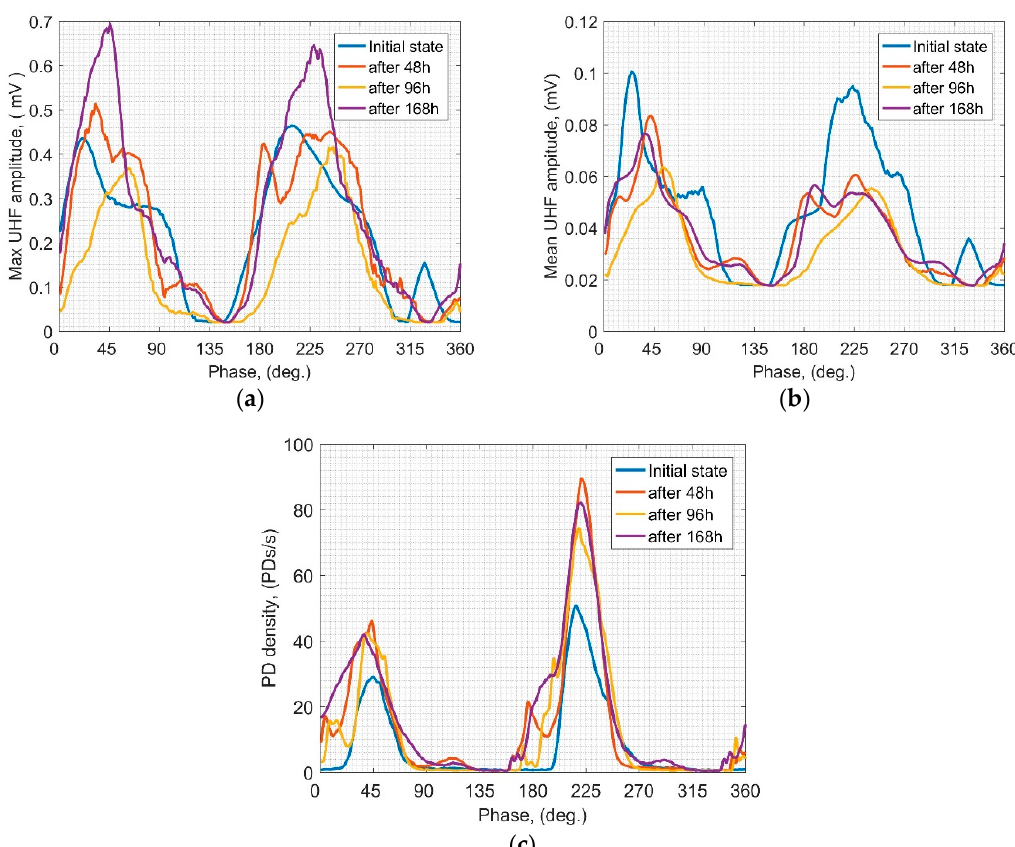
Figure 3. Means over PRPD patterns of the UHF signals emitted by SD for PBP scenario: ( a ) max UHF amplitude; ( b ) mean UHF amplitude; ( c ) PD density.